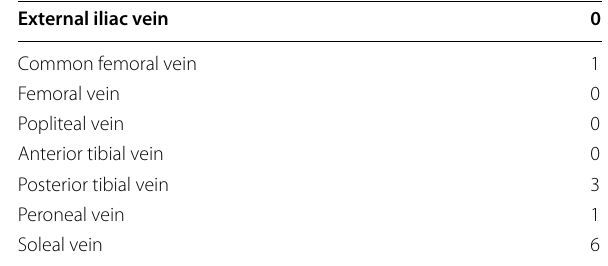
Table 1 Patient’ characteristics and results of the study